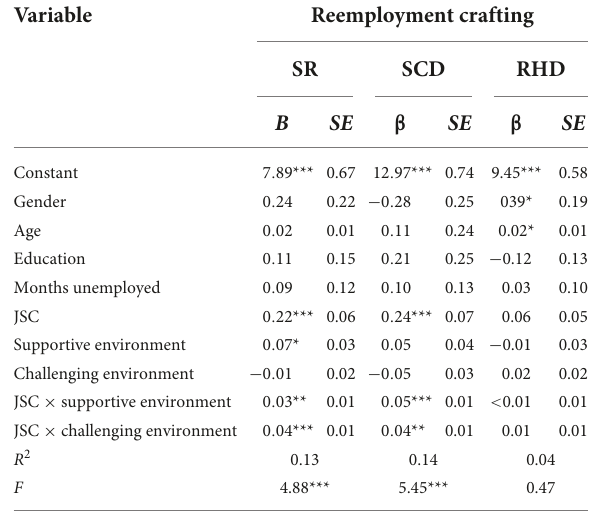
TABLE 5 Moderation effects of reemployment contexts on the relationship between JSC and reemployment crafting.